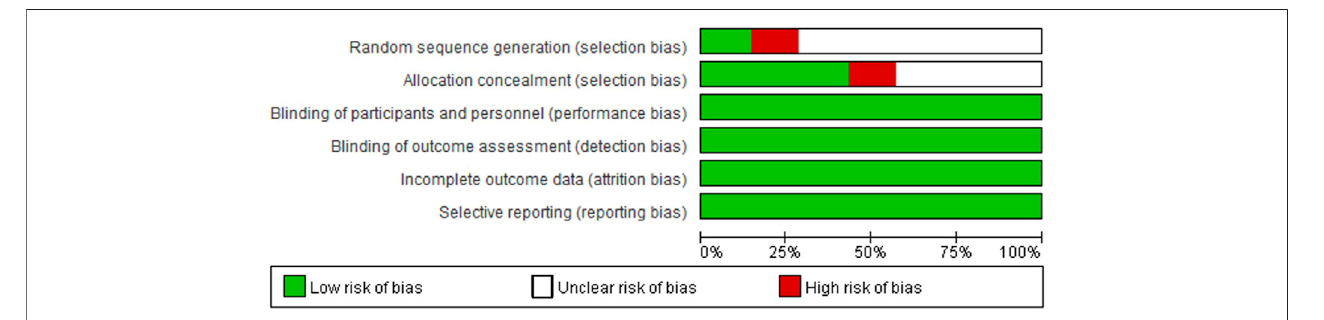
FIGURE 2 | Risk of bias graph. Adapted from Chen et al.